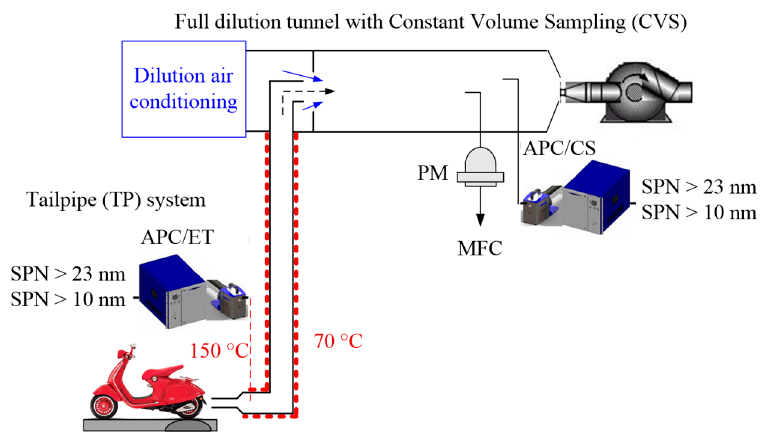
Figure 1. Experimental setup. SPN = Solid particle number; APC = AVL particle counter; ET = Experimental setup. SPN = Solid particle number; APC = AVL particle Evaporation tube; CS = Catalytic stripper; PM = Particulate matter; MFC = Mass flow controller.